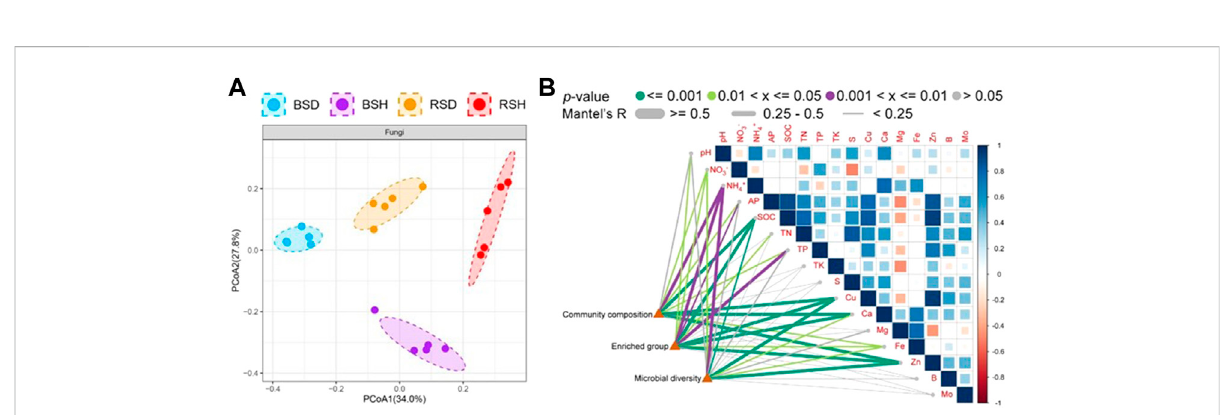
FIGURE 2 Difference analysis of beta diversity of fungi among the bulk soil of the diseased plant, the bulk soil of healthy plants, the rhizosphere soil of disease plants and the rhizosphere soil of healthy plants and pairwise correlation analysis between environmental factors and community composition, microbial diversity and enriched group (A) Principal co-ordinates analysis (PCoA) indicated the beta diversity of fungi community. Signi fi cance satis fi es p < 0.05 based on Tukey test. BSD, the bulk soil of the diseased plant; BSH, the bulk soil of healthy plants; RSD, the rhizospheresoil ofdisease plants; RSH, therhizosphere soilof healthyplants. (B) Different colors represent differentranges of p -values anddifferent degrees of signi fi cance, Signi fi cance satis fi es p < 0.05 based on Tukey test. Different line thicknesses represent different R values obtained through Manteldetection,andrepresentdifferentcorrelationdegrees.Microbialdiversitywasanalyzedatthelevelofspecies,Enrichedgroupwasanalyzedat the level of genus, and community composition was analyzed at the level of